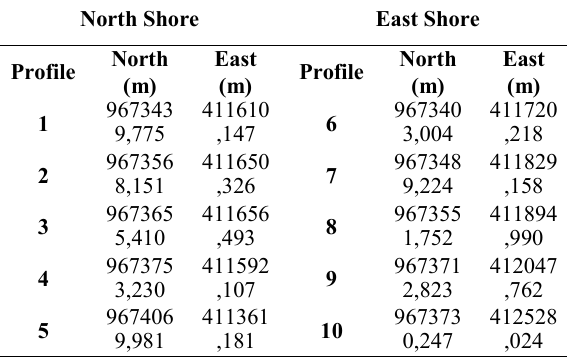
Table 2 - UTM coordinates of topographic profiles.